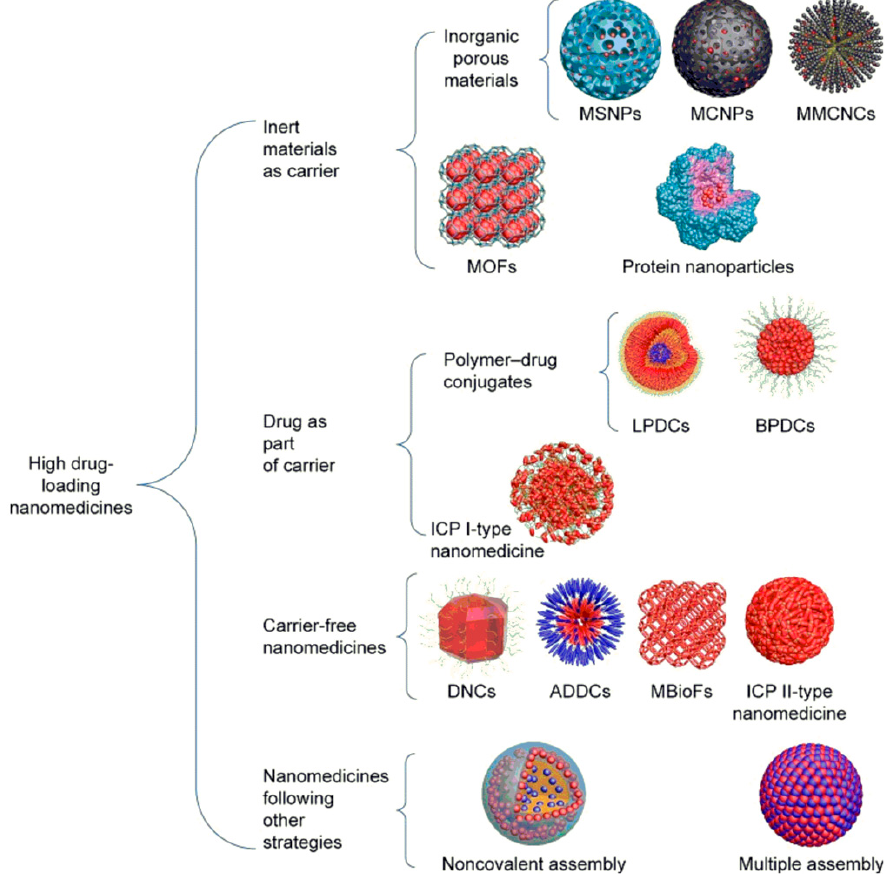
Figure 8. Schematic representation of the fabrication strategies of nanomedicines with a high drug-